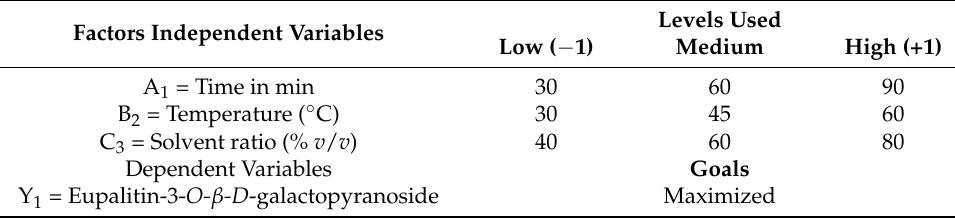
Table 4. Independent and dependent variables selected in Box–Behnken design. Factors Independent Variables